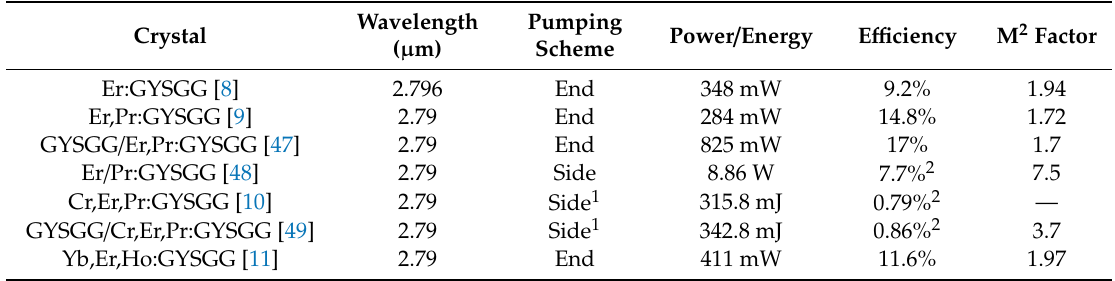
Table 4. Laser performance of Er:GYSGG and sensitizer / deactivator-doped Er:GYSGG crystals.